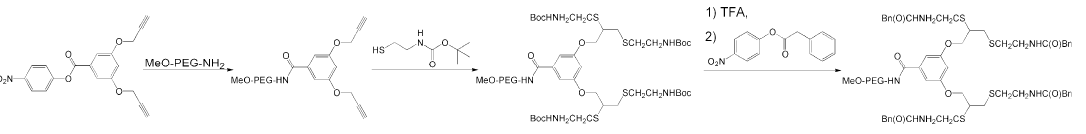
Molecules 2020 , 25 , x 16 of 31 Figure 8. PEG-poly(lysine) telodendrimer with different backbones and a variety of functional groups. Reprinted with permission from [188]. Copyright 2015 Elsevier. 4.5.2. pH-Responsive Nanocarriers An example of pH-responsive telodendrimers was published in 2004, in which linear PEG chains were used for the convergent build-up of poly(ester) or poly(lysine) dendrons, functionalized with hydrophobic and hydrolysis-active acetals. These hybrids formed stable micelles in aqueous solutions at neutral pH, and disintegrated at pH 5, due to hydrolysis of the acetals, and triggering release of the encapsulated Nile Red [189]. pH-based release of the payload has also been utilized in the reversible formation of boronate esters from boronic acids and diols [190]. PEG-poly(lysine)- cholic acid telodendrimers were prepared, and functionalized with boronic acid and catechol, respectively. The release of PTX from such cross-linked micelles was significantly slower, compared to non-cross-linked analogs. The drug release could be accelerated at lower pH, and/or in the presence of mannitol, suggesting that the latter could be used as a trigger, together with the lower pH in the tumor microenvironment. 4.5.3. Enzyme-Responsive Telodendrimer Assemblies Telodendrimer-based micelles responsive to enzymatic activity have been prepared using PEG as the linear hydrophilic block, and a dendron linked with hydrophobic phenyl acetamide moieties. The latter are responsive to penicillin G amidase, and could be cleaved using enzymatic activity [191].